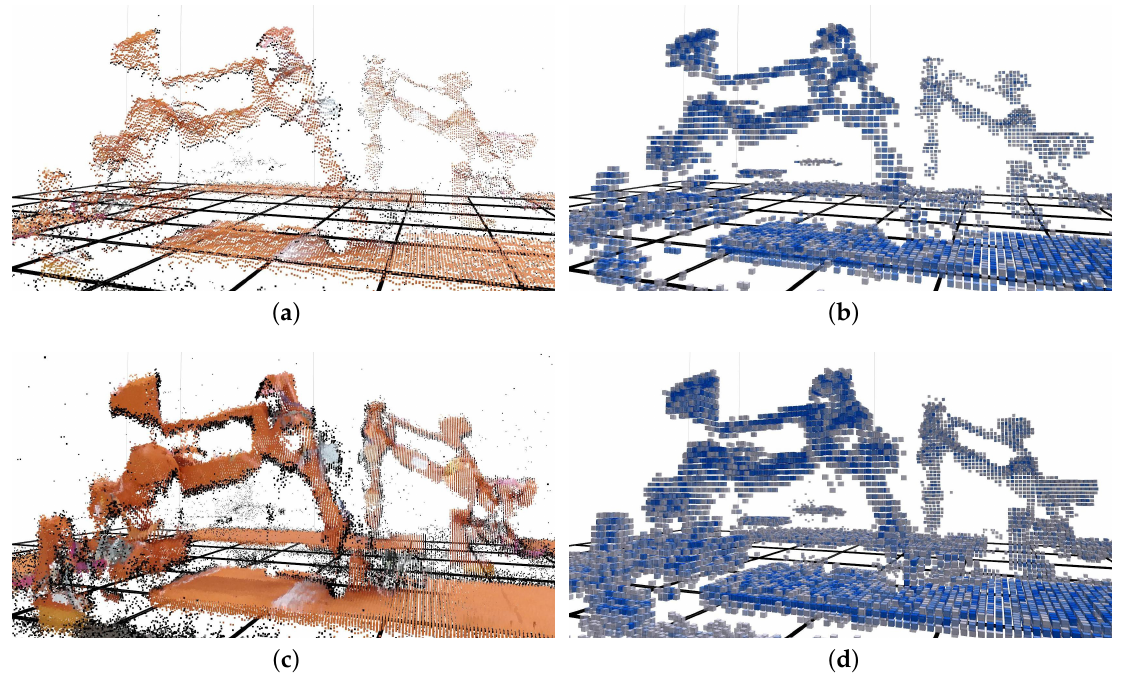
Figure 10. Visual comparison of original and compressed point clouds using a 4cm octree resolution. ( a , c ): colored point cloud generated by the Kinect V2 sensor. ( b , d ): point cloud generated by the decompressor at the central computer. For better visibility of the underlying octree structure, the points are shown as cubes with 3cm sides. A stronger color indicates higher